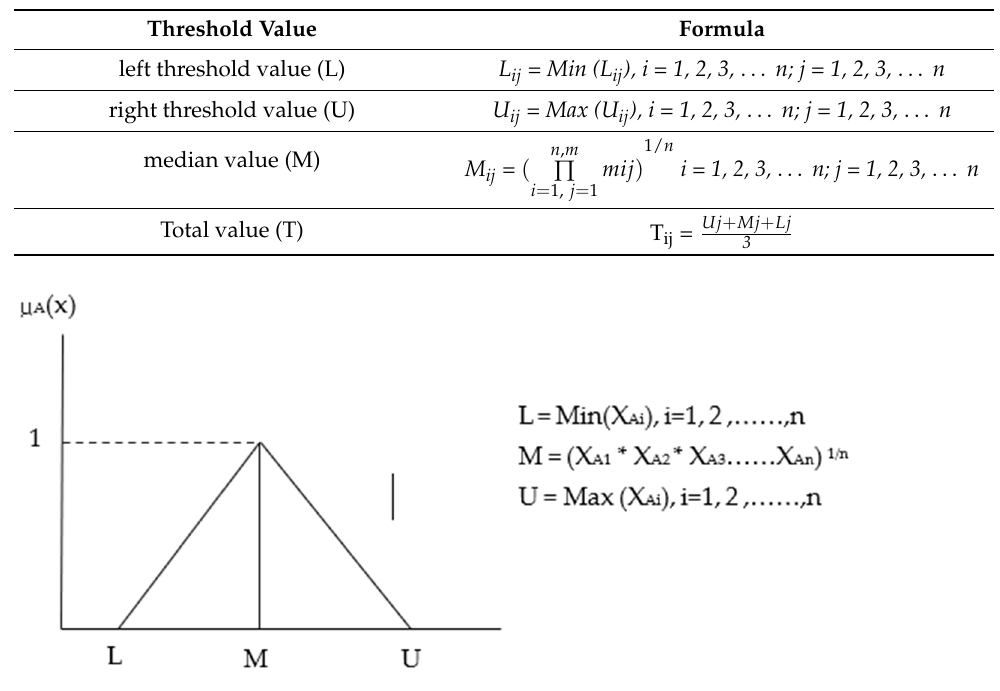
Figure 2. Graph of triangular fuzzy numbers.